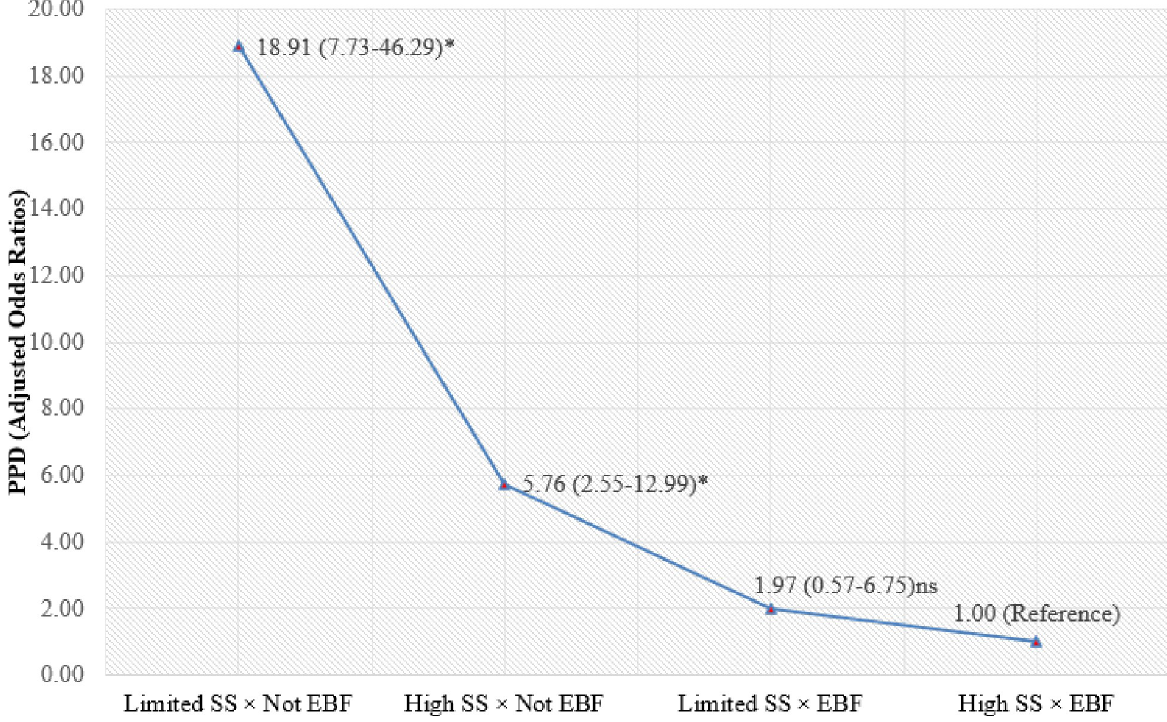
Fig 4. Combined effect of EBF and social support on postpartum depression. Controlling for maternal age, maternal education, place of residence, family monthly income, parity, pregnancy intention, obstetric complications, mode of childbirth, childhood sexual abuse, previous depressive Symptoms and maternal stress; Here � p < 0.001; SS = Social Support, EBF = Exclusive Breastfeeding.